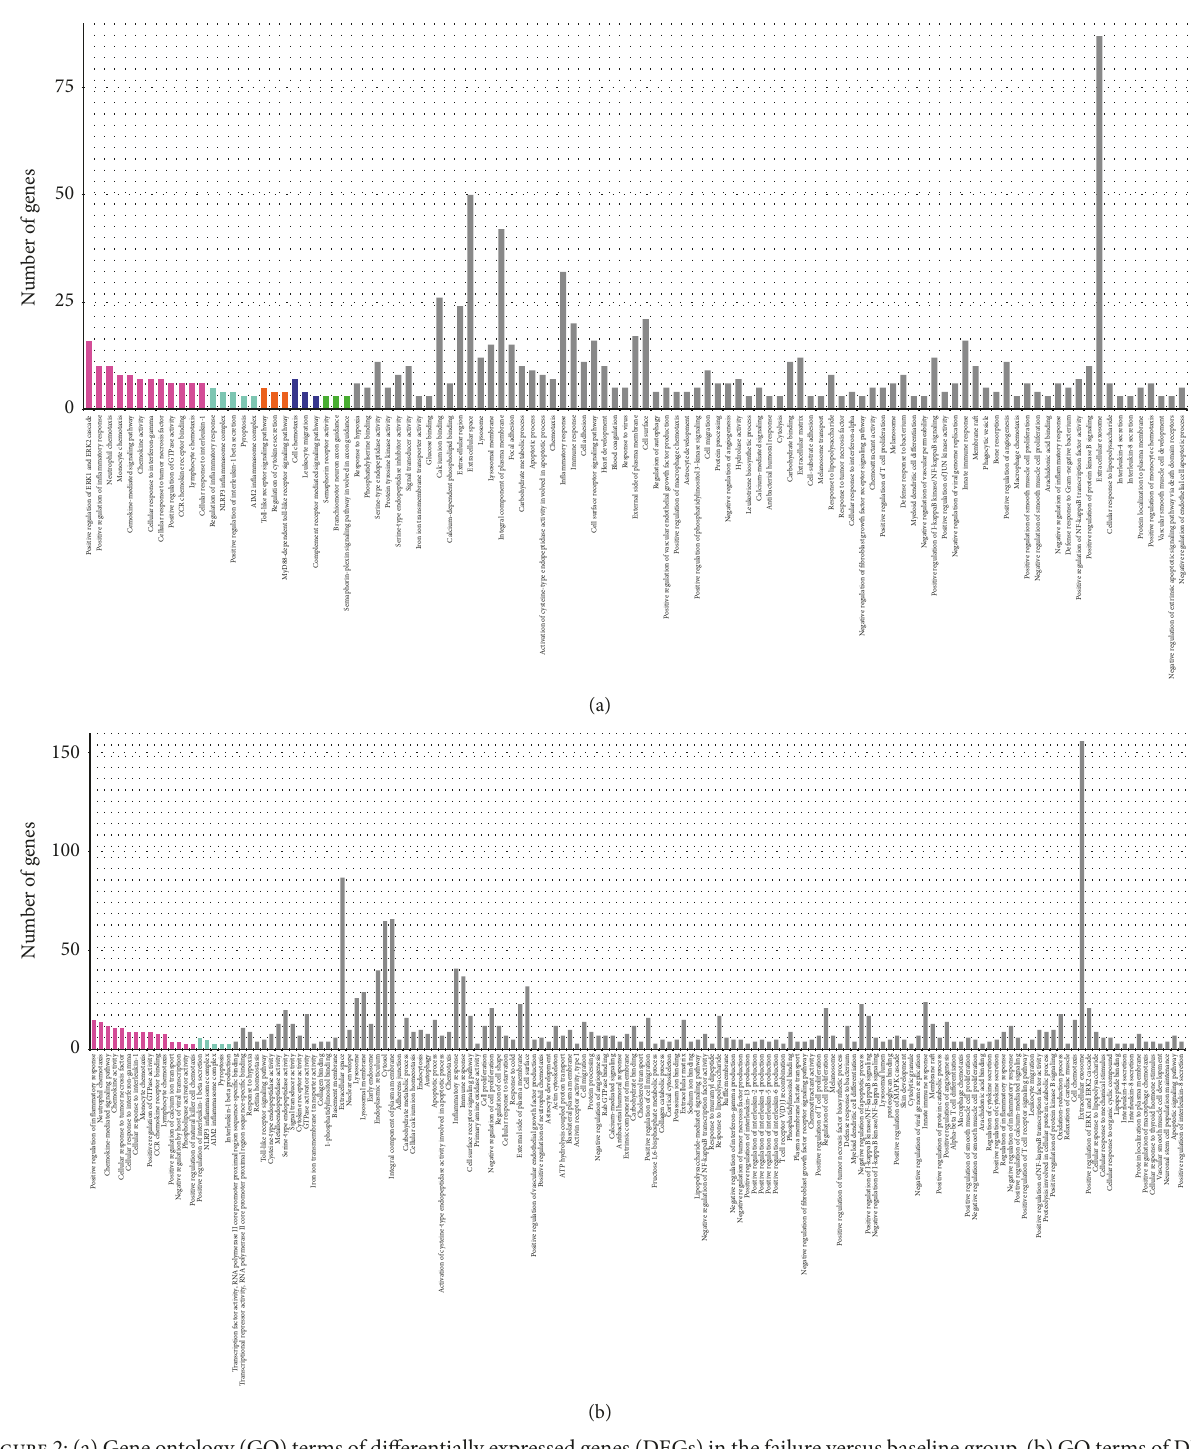
Figure 2: (a) Gene ontology (GO) terms of differentially expressed genes (DEGs) in the failure versus baseline group. (b) GO terms of DEGs in the dying versus baseline